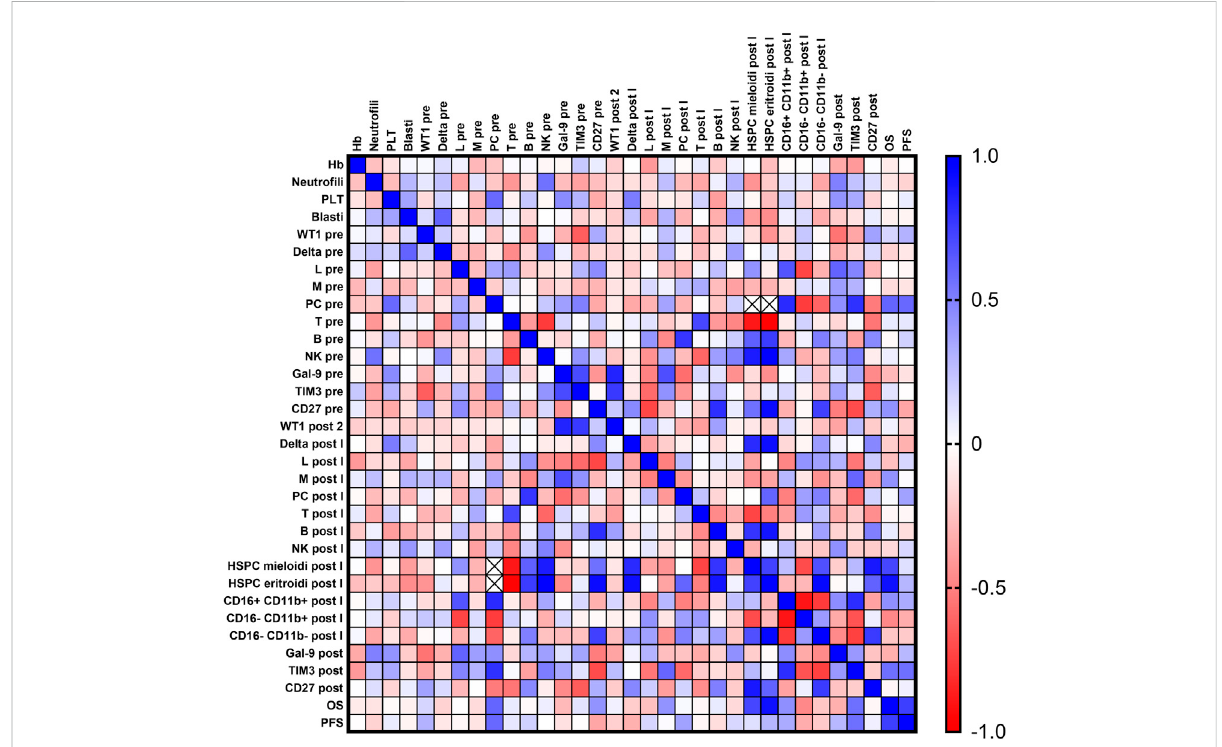
FIGURE 4 Correlation analysis. Blood counts [hemoglobin (Hb), platelet count (PLT), absolute neutrophil count (ANC)], percent of bone marrow blasts, normalized WT1 mRNAexpression, fl owcytometrydata[%oflymphocytes(Lymph),monocytes(Mono),plasmacells,TandBcells,NaturalKiller(NK) cells, myeloid and erythroid hematopoietic stem and progenitor cells (HSPCs), and granulocyte maturation curve], galectin-9 (Gal-9), Tim-3, and CD27 expression levels, overall survival (OS), and progression-free survival (PFS) were compared at baseline and after treatment by Pearson correlation analysis. Positive correlations are displayed in blue (r = 1), and negative correlations in red (r = − 1).